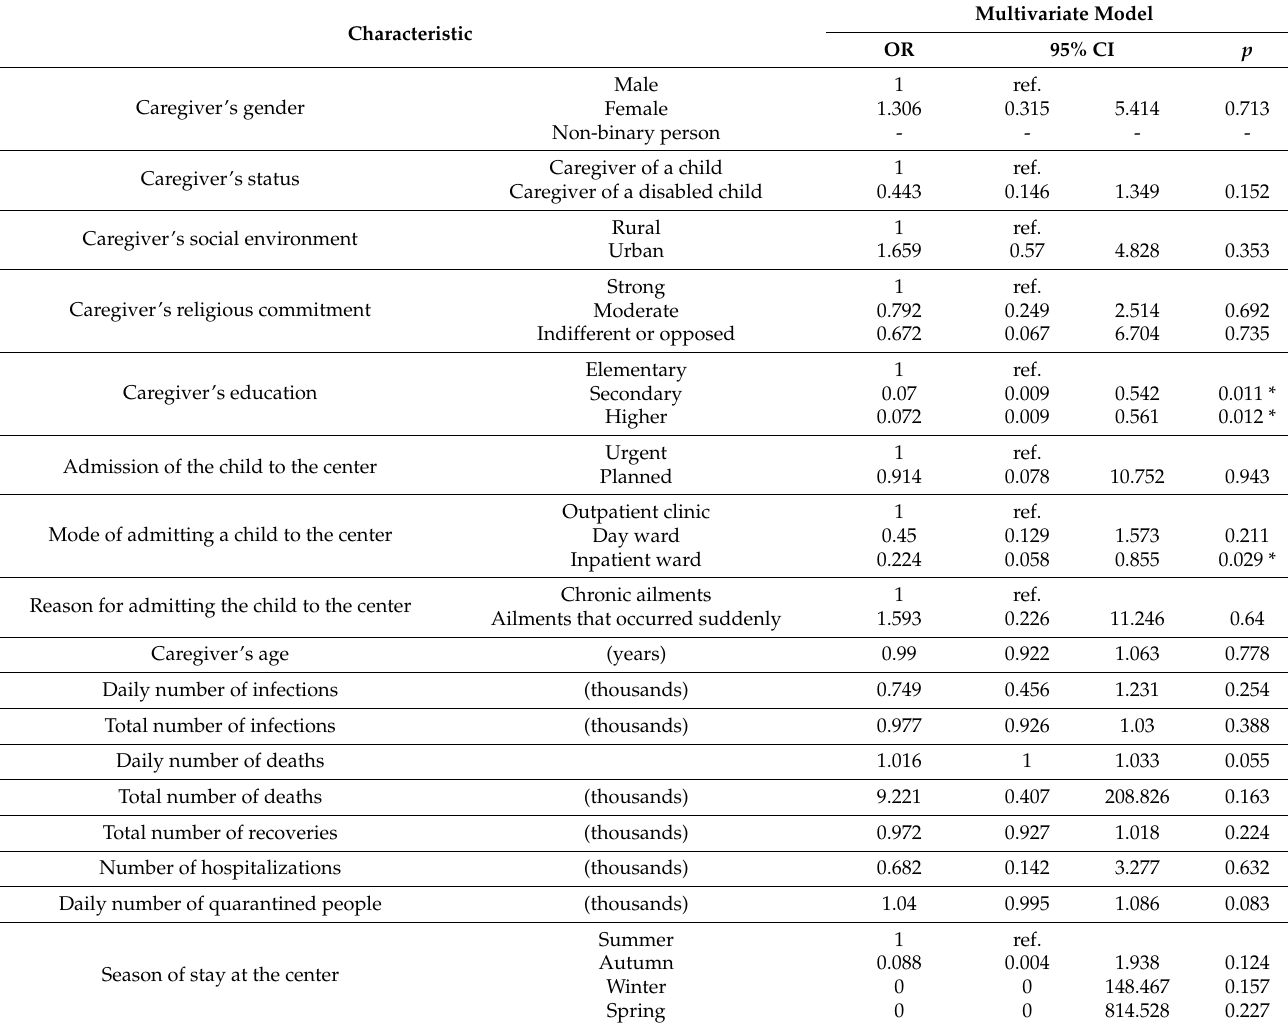
Table 13. Predictors of coexistence of anxiety and depression: multivariate analysis. Characteristic